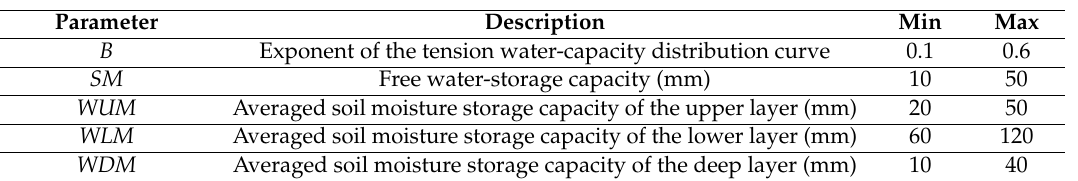
Table 1. Description of the five sensitive parameters of the XAJ model and their ranges: Minimum (Min) and Maximum